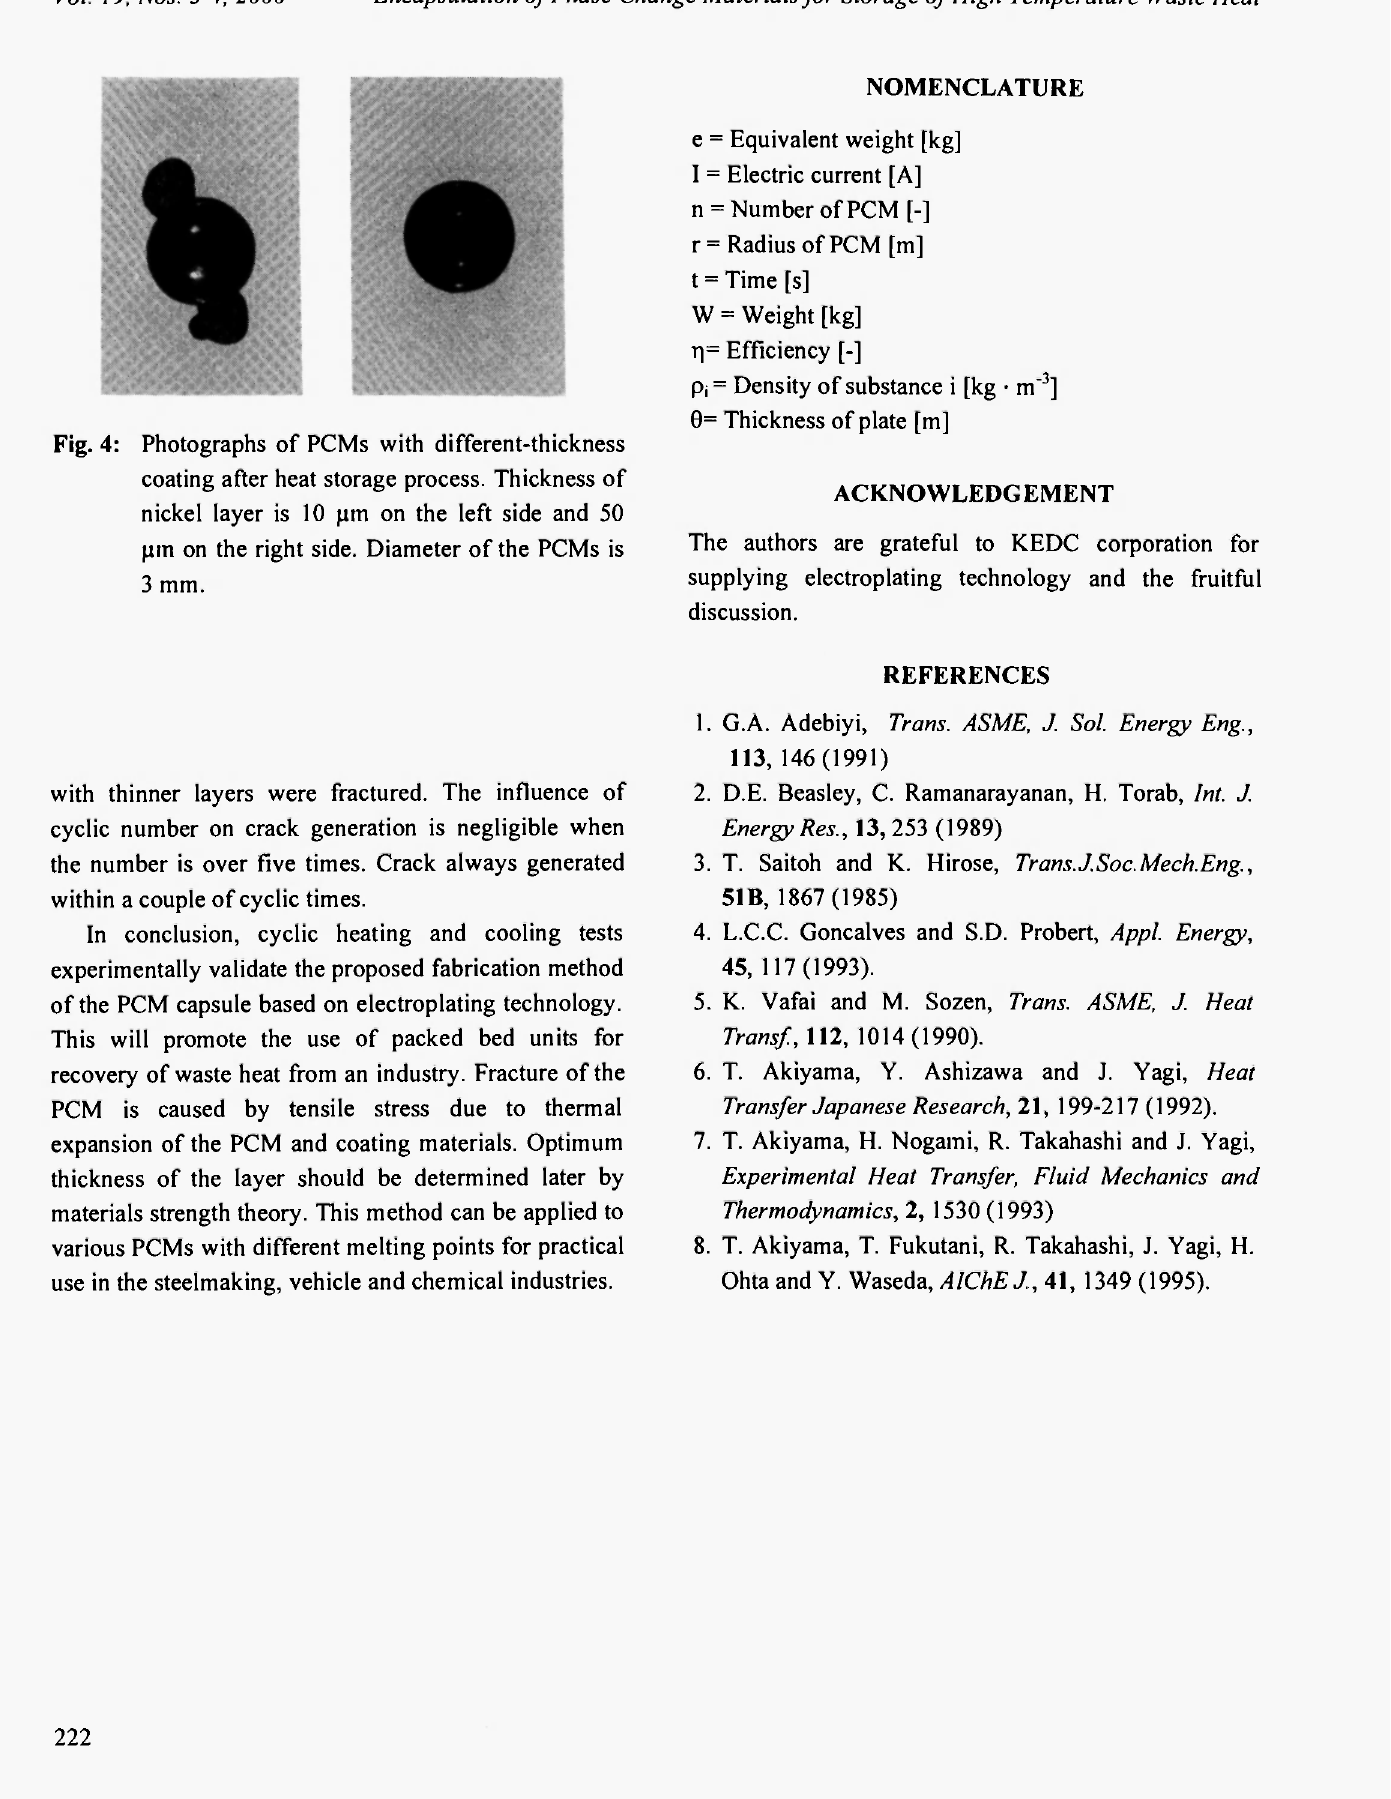
Fig. 4: Photographs of PCMs with different-thickness coating after heat storage process. Thickness of nickel layer is 10 μηι on the left side and 50 μιη on the right side. Diameter of the PCMs is 3 mm.